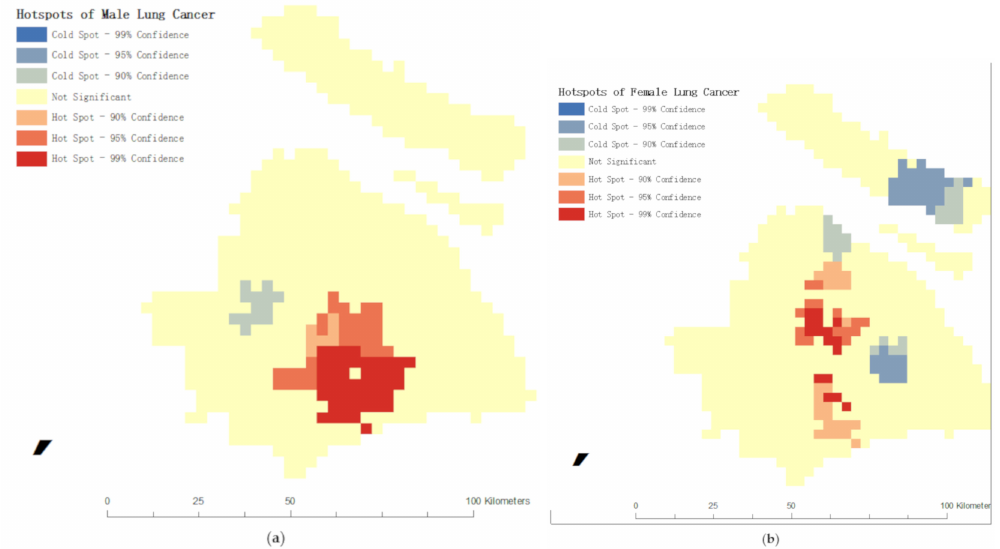
Figure 5. The result of hot spot analysis ( a ) Hotspots of male lung cancer; ( b ) Hotspots of female lung